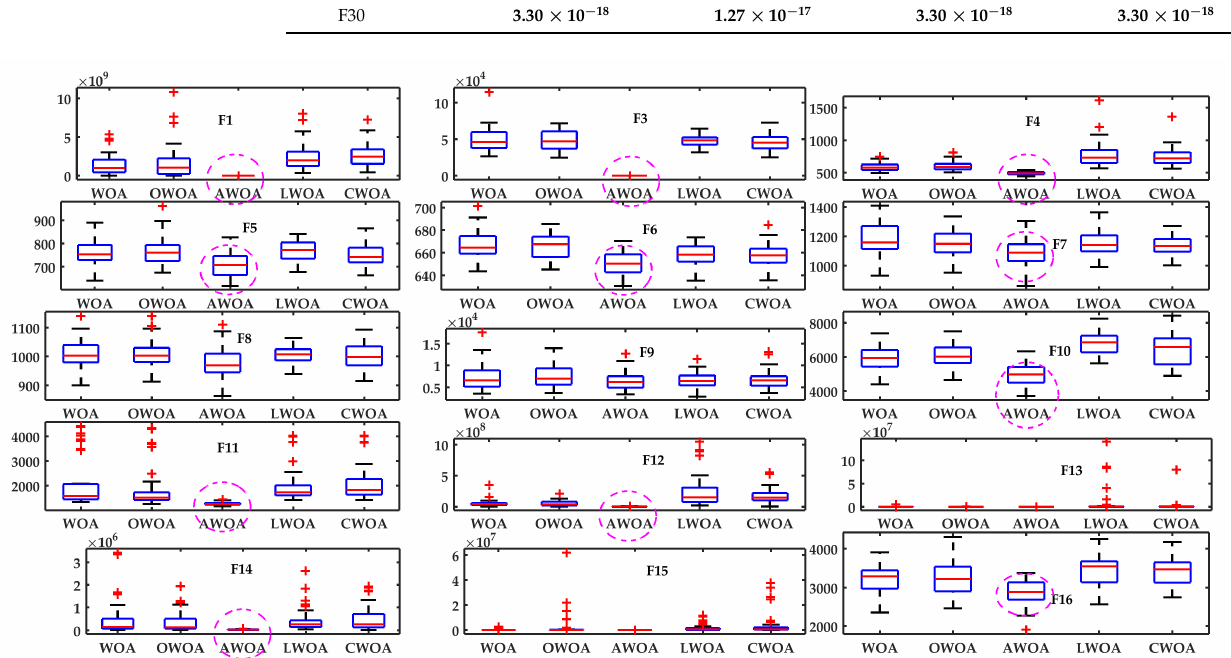
Figure 11. Boxplot analysis of the 30D functions of Benchmark Suite